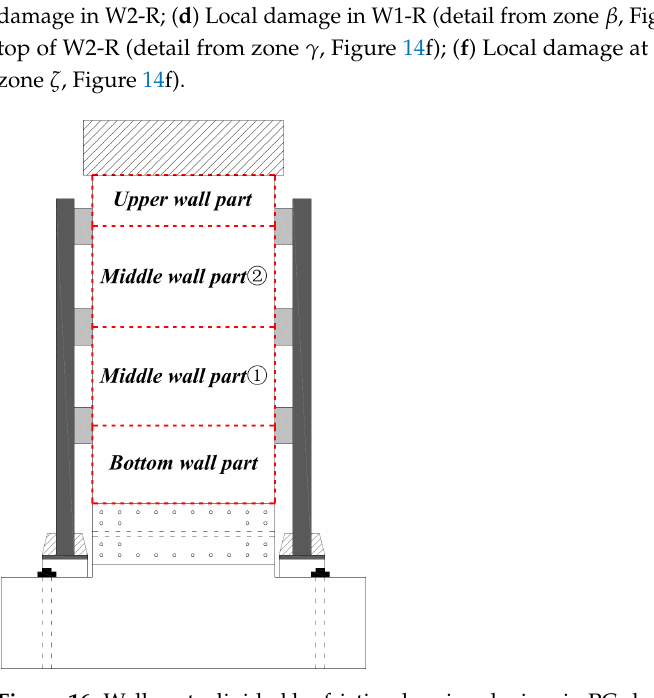
Figure 16. Wall parts divided by friction-bearing devices in PC shear